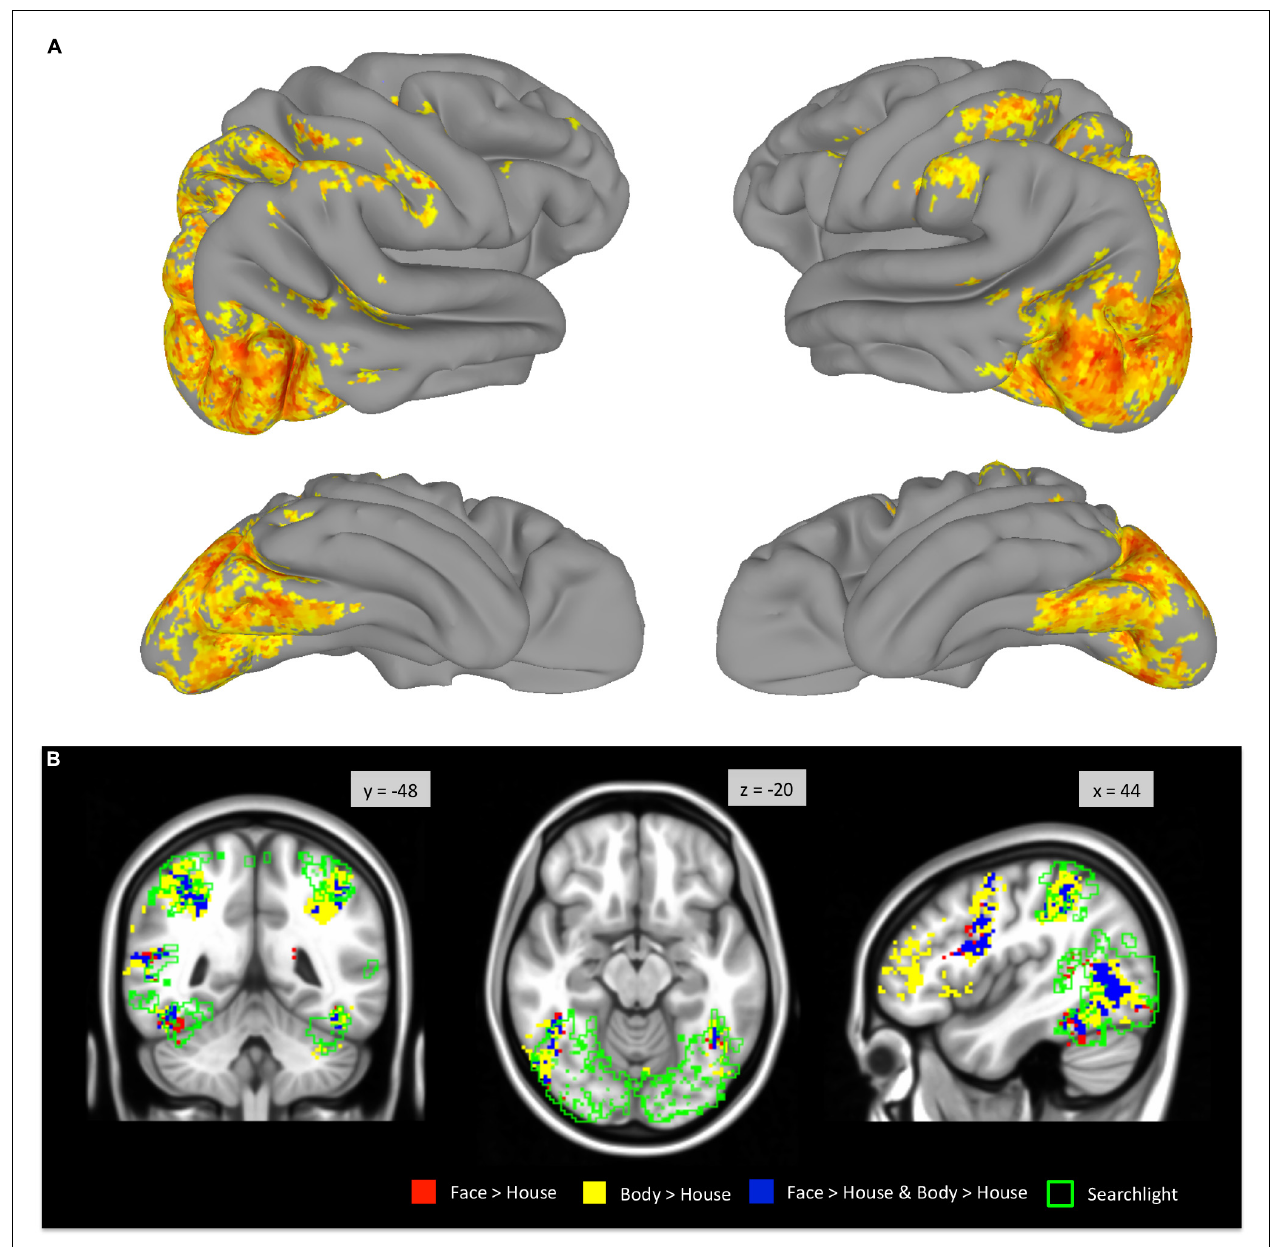
FIGURE 7 |Whole-brain searchlight analysis. (A) Areas that survived FDR correction are displayed on the surface of the standard brain. (B) Voxels that survived FDR correction are outlined in green and overlaid on the group-level GLM contrast maps (derived from Figure 2 ).